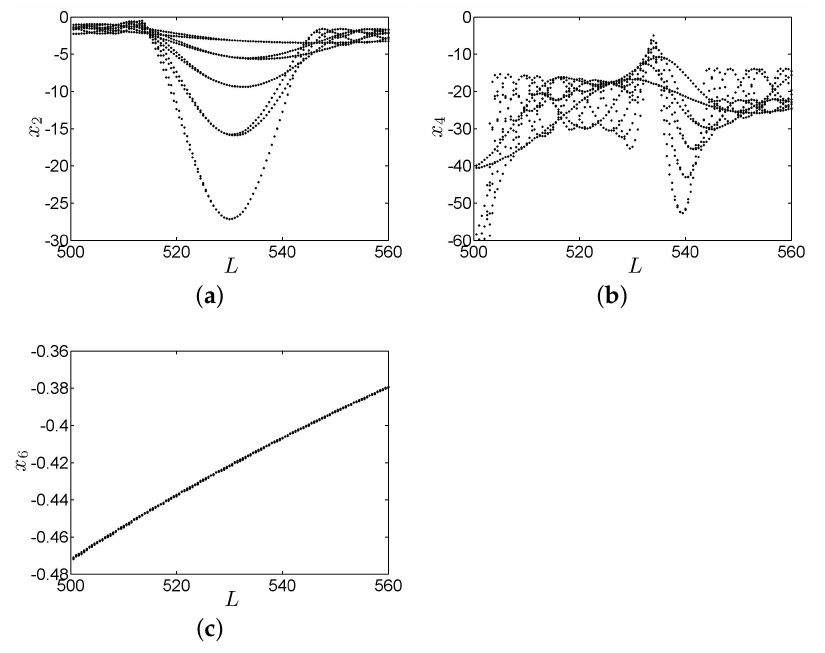
Figure 7. The bifurcation diagram with different length. ( a ) The axial bifurcation. ( b ) The torsional bifurcation. ( c ) The lateral